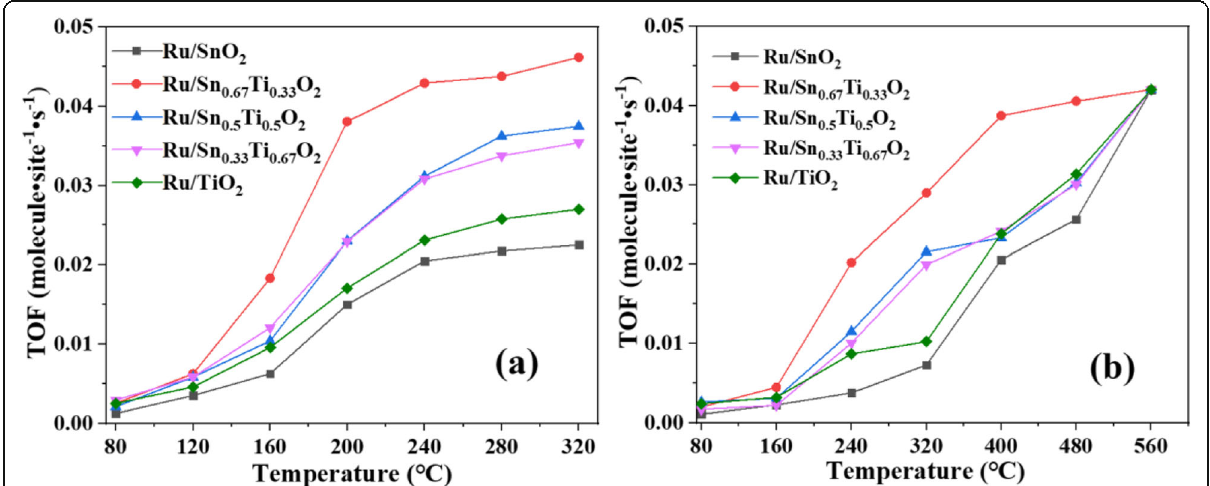
Fig. 2 TOF of reaction temperature for CO ( a ) and C 3 H 8 ( b ) oxidation over various